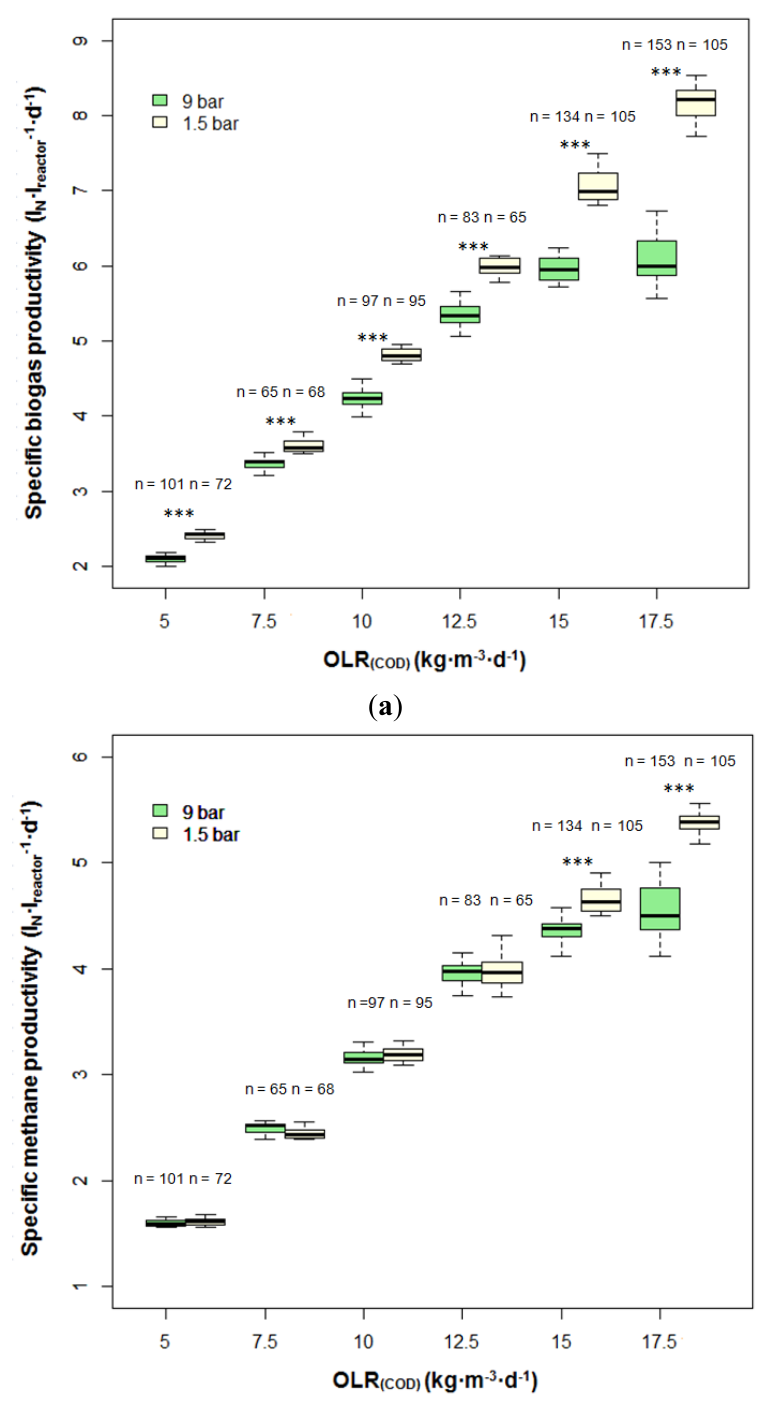
Figure 2. ( a ) Specific biogas productivity ( b ) Specific methane productivity at different OLR and pressure levels. The box plot is characterized with the minimum, low quartile, median, upper quartile and maximum value. Significant differences among the pressure levels are marked with asterisks (“***”: p < 0.001; “**”: p < 0.01; “*”: p < 0.05, LSD